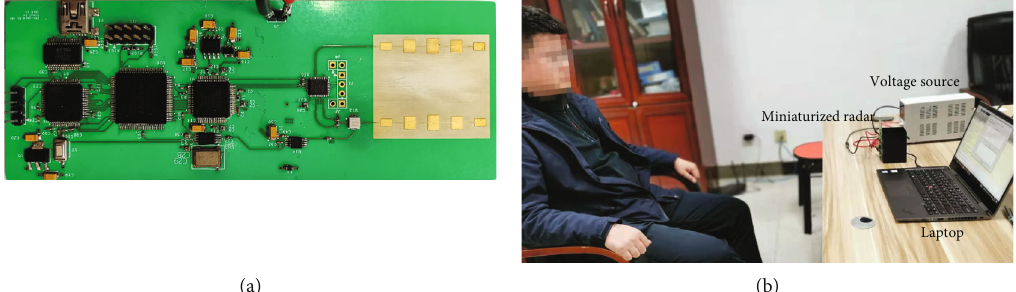
Figure 8: (a) The enlarged radar circuits viewed from front side and back side; (b) the setup of the experiment, including miniaturized radar, voltage source, laptop, and the subject under detection.